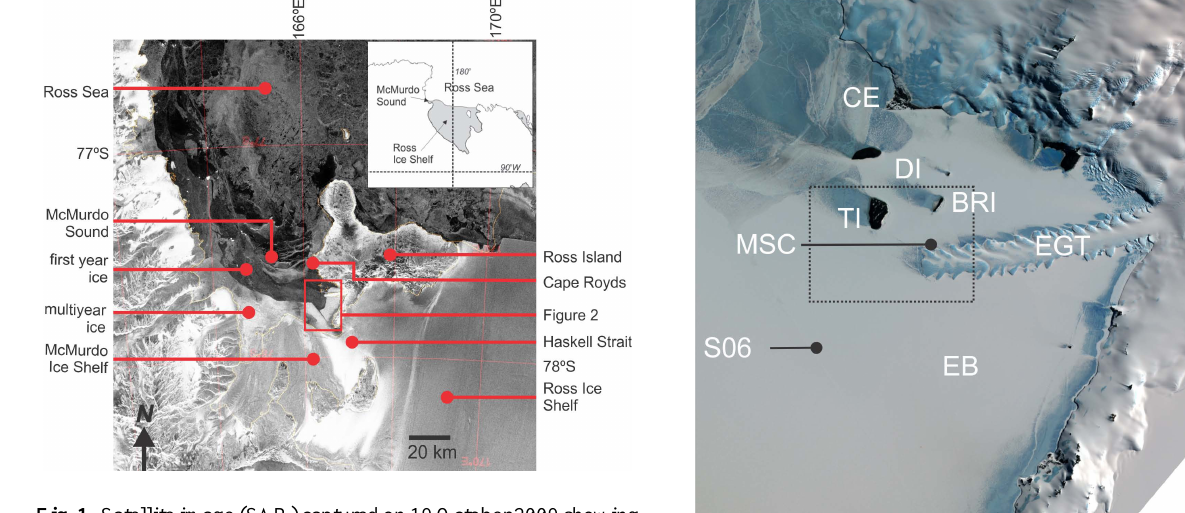
Fig. 1. Satellite image (SAR) captured on 19 October 2009 showing McMurdo Sound located in the south western Ross Sea connected to the Ross Ice Shelf cavity via Haskell Strait beneath the McMurdo Ice Shelf. The greyscales give an indication of open water and pack ice off Cape Royds and the first year and multiyear ice in the Sound. The inset shows the locale within the western Ross Sea.